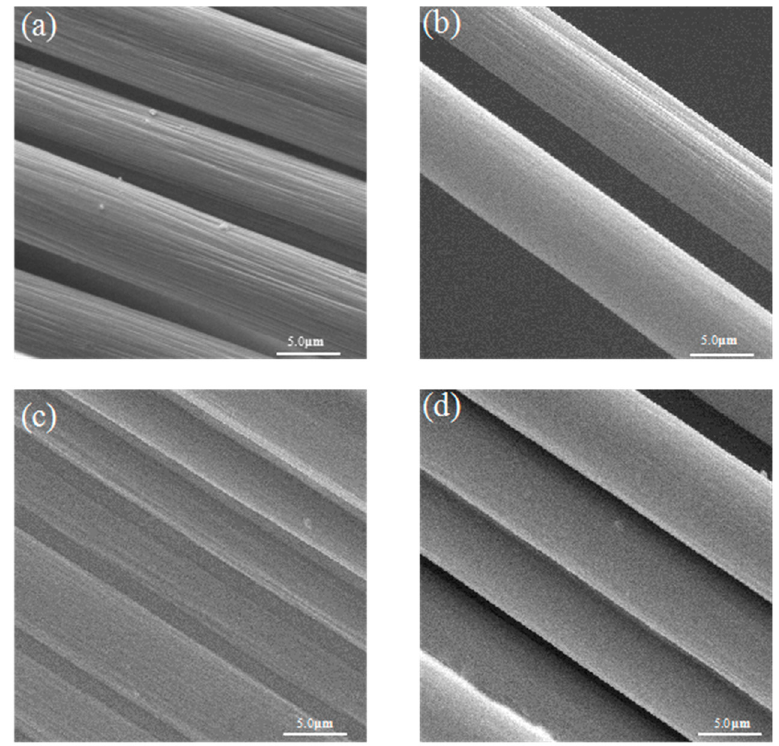
Figure 10. SEM micrographs of the CF surface: ( a ) unsized, ( b ) S1-sized, ( c ) S2-sized and ( d ) S-3 sized.